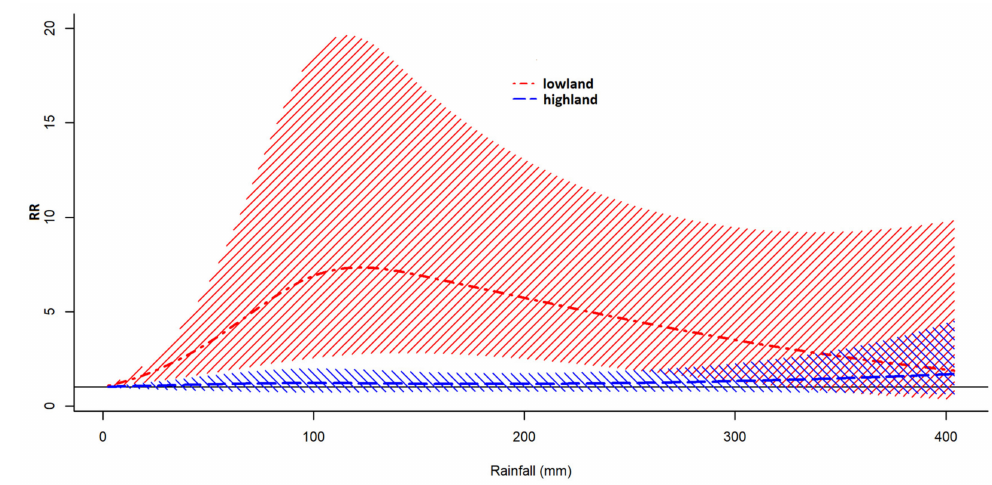
Figure 3. Pooled overall rainfall–malaria associations by area.